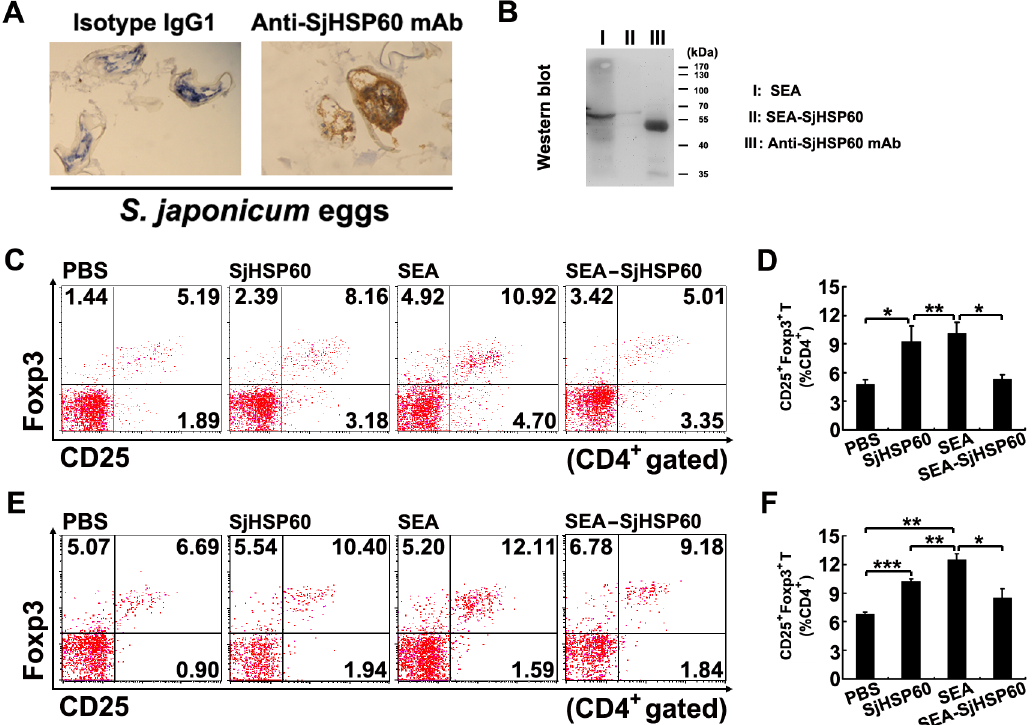
Fig 2. SjHSP60-depleted SEA showed impaired ability of Treg induction. (A) Immunohistochemical detection was carried out with the anti-SjHSP60 mAb and isotype-matched antibody. Original magnification: 400×. (B) The depletion of SjHSP60 from SEA was proved by Western blot. Equal amounts of SEA and SjHSP60-depleted SEA were loaded. Anti-SjHSP60 mAb (heavy chain (cid:1) 50 kDa, light chain (cid:1) 25 kDa) was loaded as a control. Shown is one representative result from three independent experiments. (C and D) Total spleen cells from normal mice were cultured in the presence or absence of 0.2 μ g/ ml SjHSP60, 20 μ g/ml SEA or 20 μ g/ml SjHSP60-depleted SEA. After 3 days, cells were collected and CD4 + CD25 + Foxp3 + Tregs were identified by FCM. (E and F) Mice were injected with SjHSP60, SEA or SjHSP60-depleted SEA. Ten days after the final injection, CD4 + CD25 + Foxp3 + Tregs in spleen of individual mice were analyzed by FCM. Five mice were used in each experimental group. FCM plots are representative of one of three independent experiments. Cells were gated on CD4 + T cells. All bar graphs indicate average percentages ± SD of CD4 + CD25 + Foxp3 + Tregs representative of one of three independent experiments. * P < 0.05, ** P < 0.01, *** P <